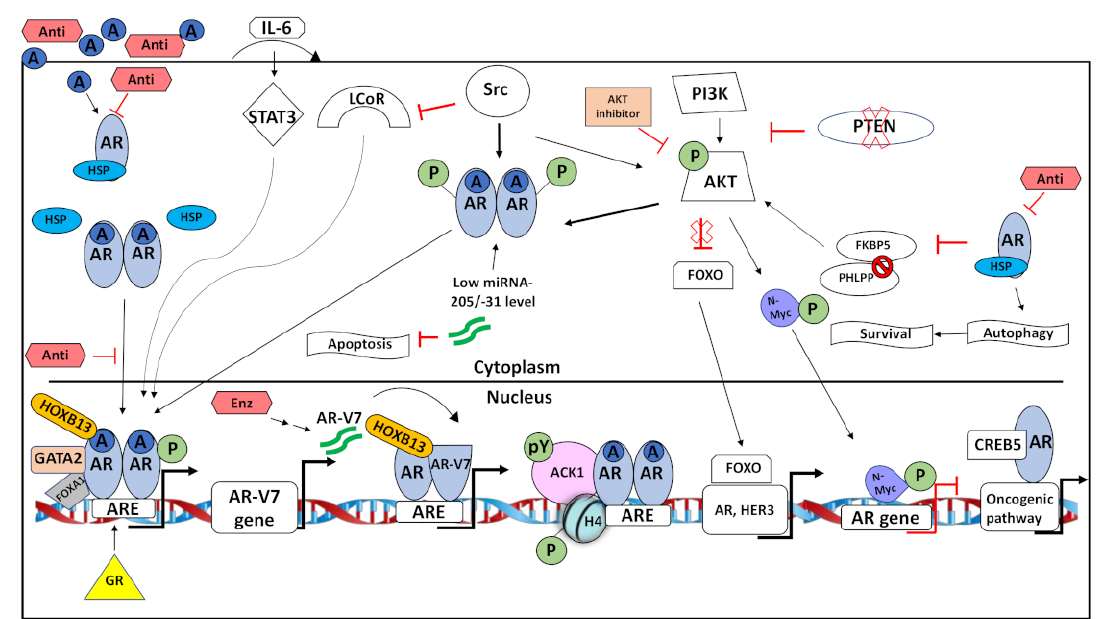
Figure 2. Summary of some adaptive AR signaling pathways active in DRPC. Androgens and AR-antagonists (Anti) diffuse into PCa cells. Androgens bind and activate the androgen receptor (AR) in the cytoplasm. The AR dissociates from HSP, forms a dimer and translocates into the nucleus. Antagonists inhibit androgen-activated AR by various biochemical mechanisms and block activation of AR signaling. At chromatin, co-regulators such as pioneering factors, co-activators and co-repressors modulate transcriptional activity of AR at androgen response elements (ARE). Adaptive signaling that lead to CRPC includes the upregulation of glucocorticoid receptor (GR) that can bind to AREs and can activate AR signaling despite AR inhibition. Through autocrine signaling IL-6 activates STAT3 that in turn phosphorylates AR and thereby enhancing AR-mediated transactivation. The second-generation AR antagonist Enzalutamide (Enz) increases the expression of AR-V7 variant associated with aggressive PCa and dimerizes with AR to change AR transcriptome landscape. Activation of Src kinase phosphorylates AR and AKT. Both Src and AKT interact with AR and phosphorylate AR to enhance its nuclear translocation. Additionally, Src kinase inhibits LCoR and thereby inactivating its function as co-repressor of AR. Low expression of miRNA-205/-31 stabilizes AR protein and blocks apoptosis. Phosphorylated ACK1/AR complex phosphorylates chromatin and increases accessibility to target genes. PTEN loss results in active PI3K/AKT signaling. Active AKT phosphorylates AR and N-myc. Phosphorylated AR translocates to the nucleus and induces expression of ARE. N-Myc represses AR gene expression. AKT inhibition blocks repression of FOXO by AKT. Hence, FOXO is active and induces expression of genes such as AR and HER3. Inhibition of AR by anti-androgens downregulates FKBP5 expression. Therefore, FKBP5 cannot act as a chaperone of PHLPP leading to the hyperphosphorylation of AKT. AR inhibition by AR further induces pro-survival autophagy. CREB5 forms a complex with AR, resulting into expression of genes involved in oncogenic